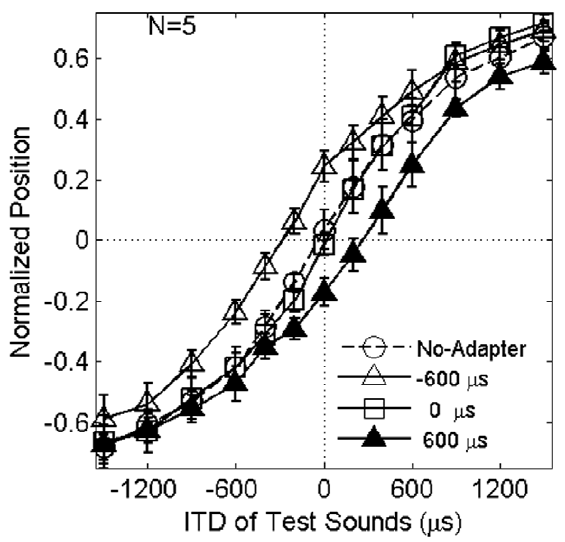
Figure 1. Average normalized responses as a function of the ITD of the test stimulus. Error bars represent standard errors. After the adaptation at 6 600 m s, the subjective midline shifted towards the position of the adapter. Error bars show SEs.